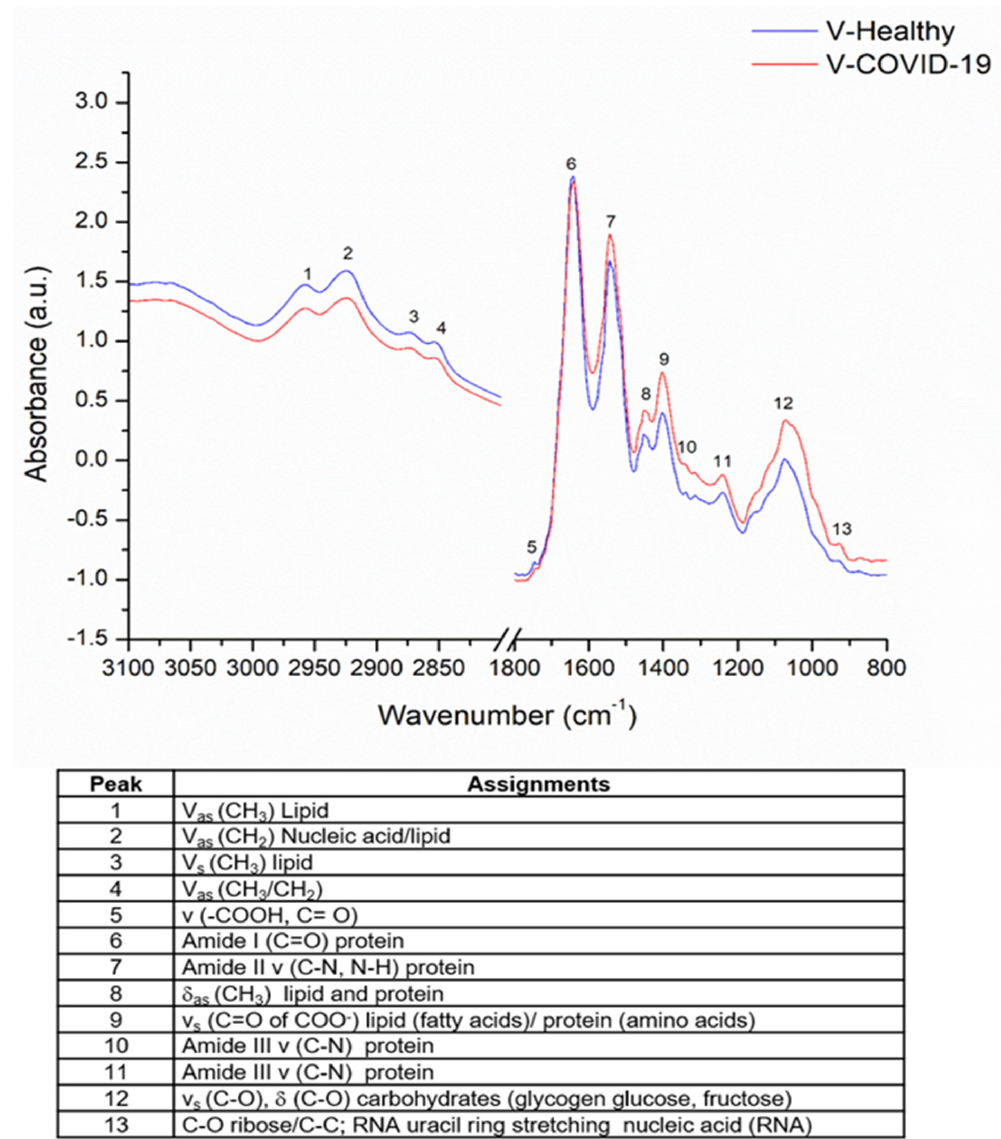
Figure 2. Mean of FTIR spectra of V-COVID-19 ( n = 50) and V-Healthy ( n = 135) groups. The spectra of the V-COVID-19 group are represented in red and the spectra of the V-Healthy group are in blue.